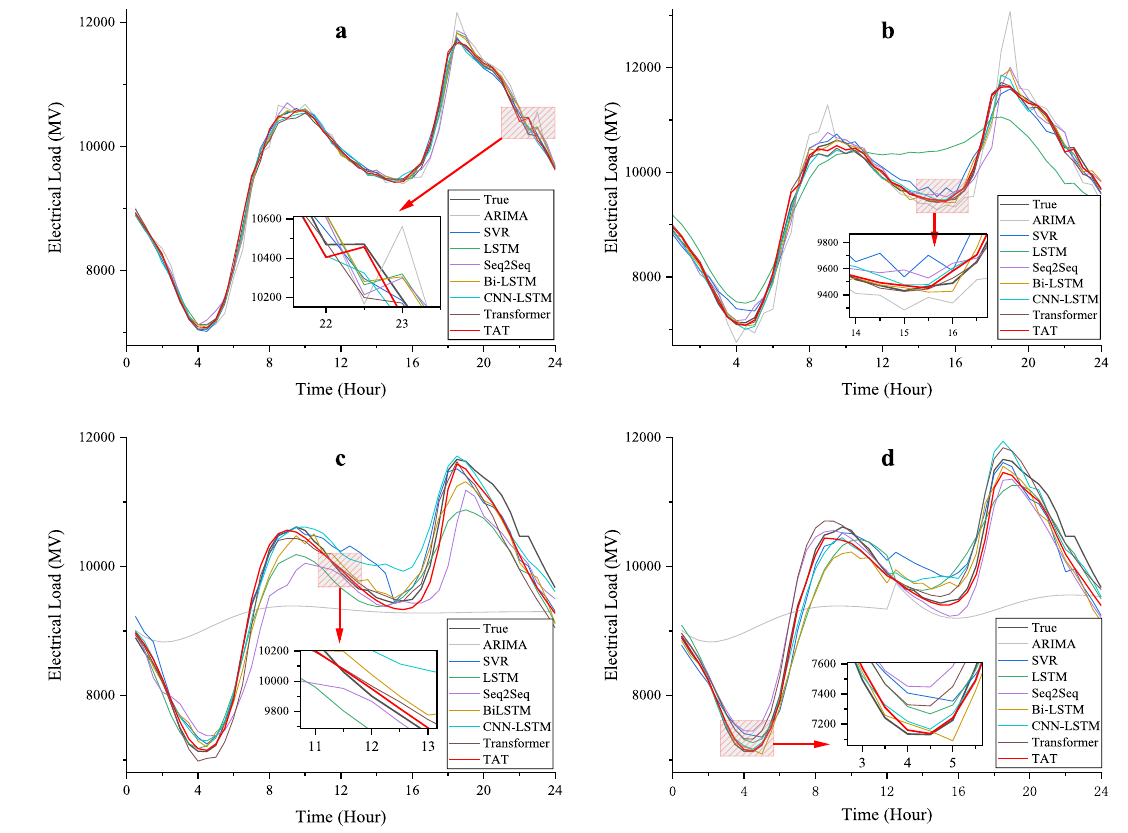
Table 2 Comparison of performance for multi-step forecasting under the univariate and multivariate variable input